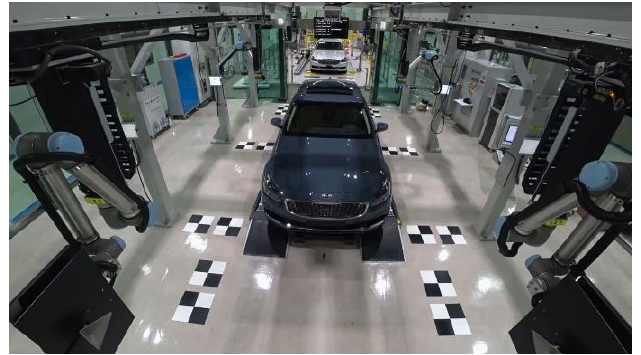
Figure 2. The AVM calibration facility.